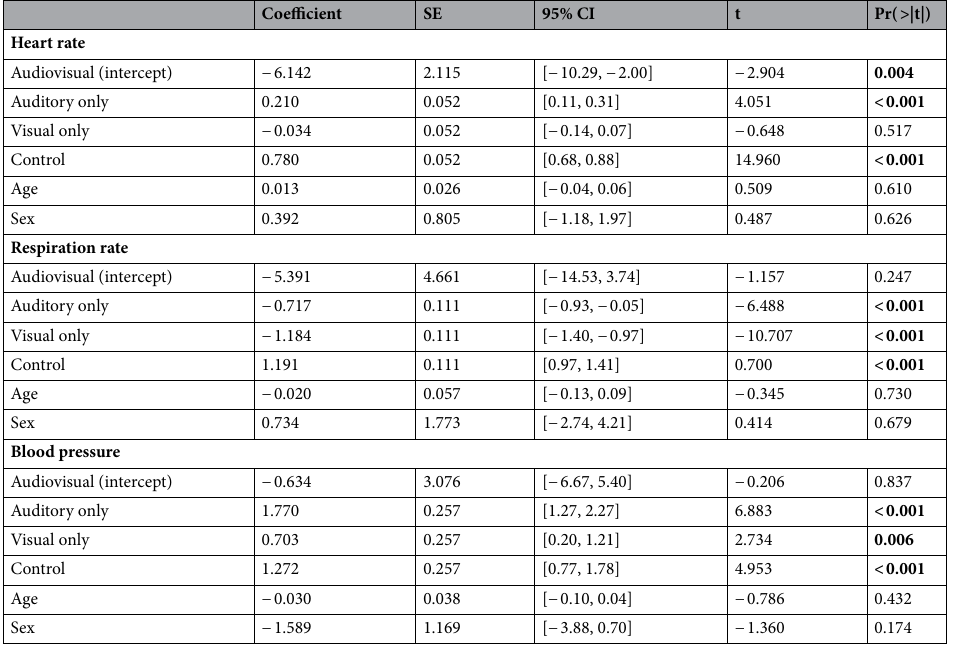
Table 3. Generalized additive mixed model (GAMM) for the heart rate, respiration rate, and blood pressure. For each model, the coefficient representing the intercept of the data and its significance is shown. The sampling frequency is 12 samples/min for heart rate (t(59,951)) and respiration rate (t(59,951)), and 0.5 samples/min for blood pressure (t(2502)). Intercept data has no practical meaning as the model could not be set to zero 48,49 . Abbreviations: standard error (SE), confidence interval (CI), test statistic with sample size used for the predictions in the model (t( )), proportion of the t distribution at that df which is greater than the absolute value of your t statistic (PR( >|t|)). Significant p-values are in